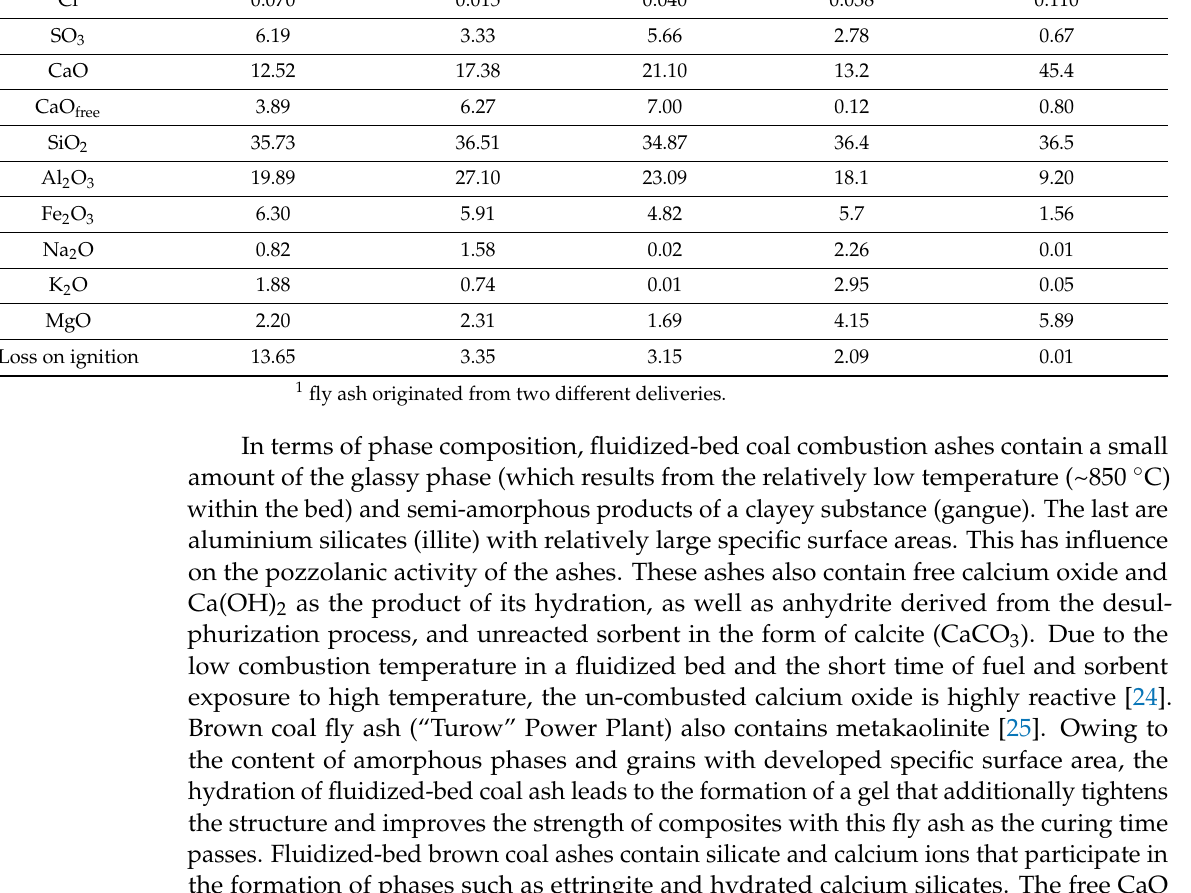
Table 2. Oxide composition in CBPs and blast furnace slag used in hardening slurry tests.